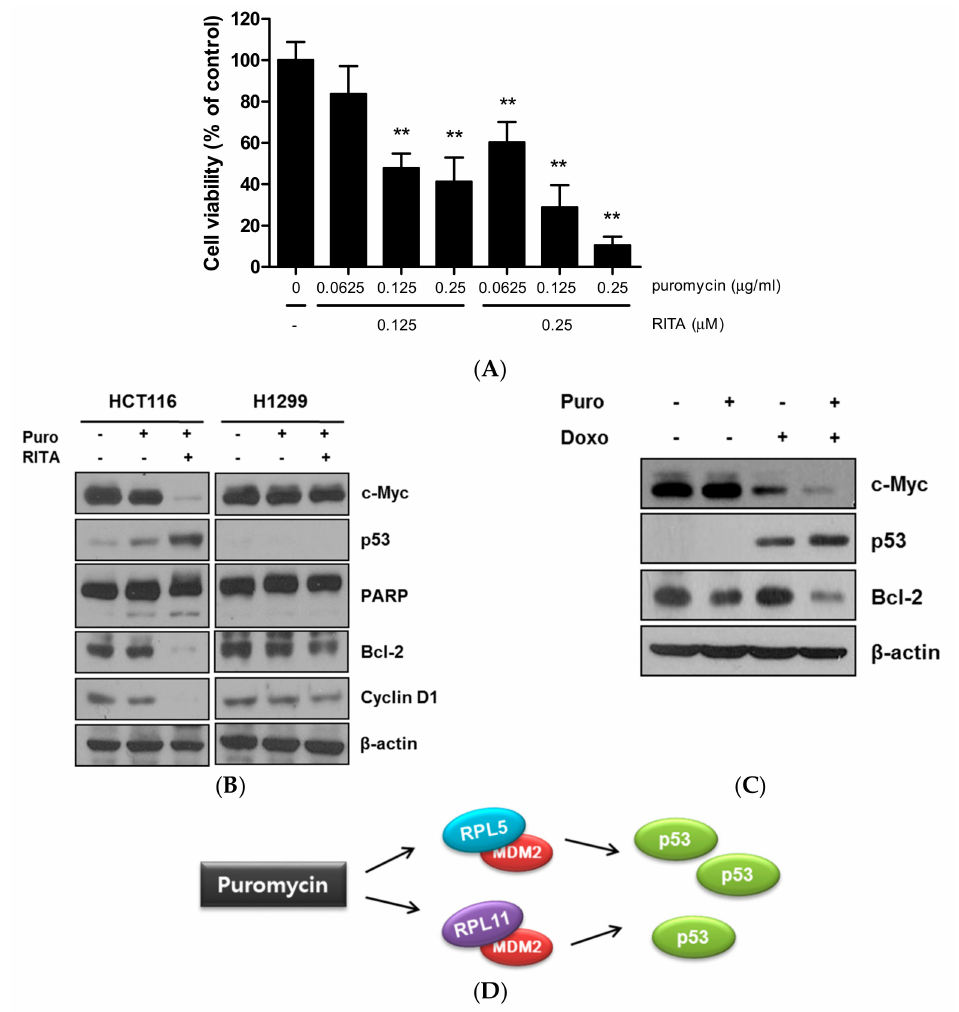
Figure 5. Combination e ff ect of puromycin and reactivating p53 and inducing tumor apoptosis (RITA) or doxorubicin in cancer cells. ( A ) Synergistic e ff ect of puromycin and RITA on cytotoxicity in HCT116 cells. HCT116 cells were treated with various concentrations of puromycin and RITA for 24 h, and cytotoxicity was evaluated by using MTT assay. **, p < 0.001 vs. untreated control. ( B ) Combination e ff ect of puromycin and RITA on c-Myc, p53, PARP, Bcl-2, and cyclin D1 in HCT116 and H1299 cells. HCT116 and H1299 cells were treated with or without puromycin or / and RITA for 24 h. Western blotting was performed with antibodies of c-Myc, p53, PARP, Bcl-2, cyclin D1, and β -actin. ( C ) Combination e ff ect of puromycin and doxorubicin on c-Myc, p53 and Bcl-2 in HCT116 cells. HCT116 cells were treated with or without puromycin (0.25 µ g / mL) and doxorubicin (1 µ M) for 24 h and subjected to Western blotting for c-Myc, p53, Bcl-2, and β -actin. ( D ) A mechanistic scheme for puromycin-induced p53 dependent apoptosis via interaction between MDM2 and RPL5 /